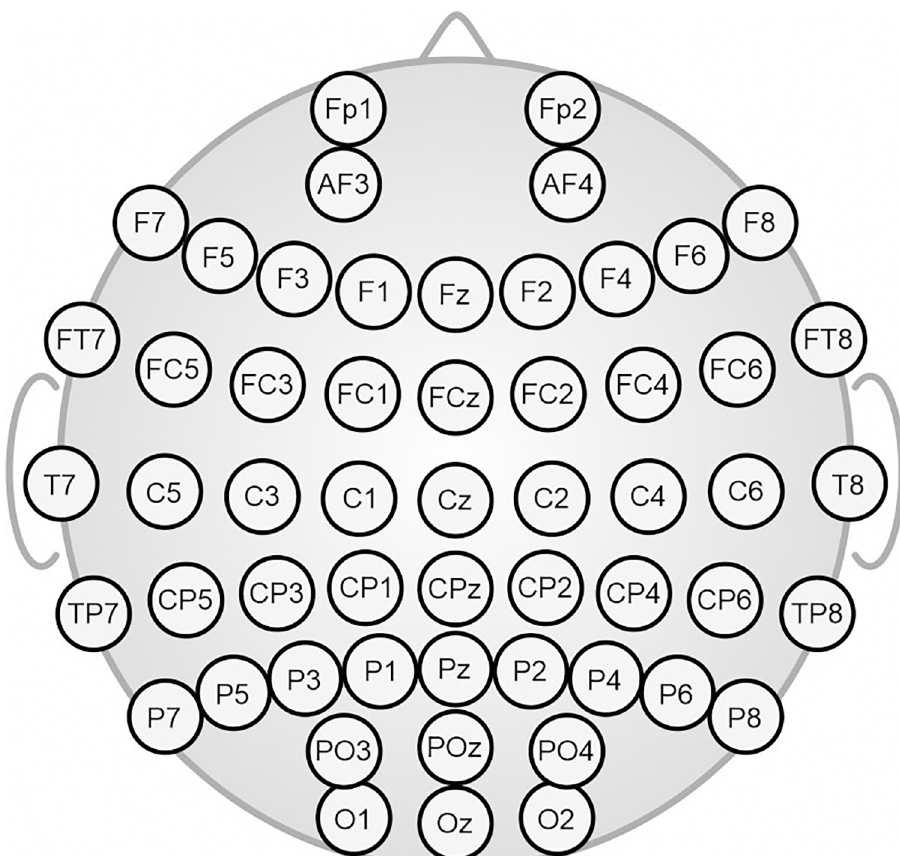
Fig 1. Extended 10–20 subset comprising 55 channels contained in and extracted from datasets 1–4. For datasets 5 and 6, 55 electrode positions of the 256-channel equidistant electrode arrangement with minimum Euclidean distance to the shown 10–20 positions have been